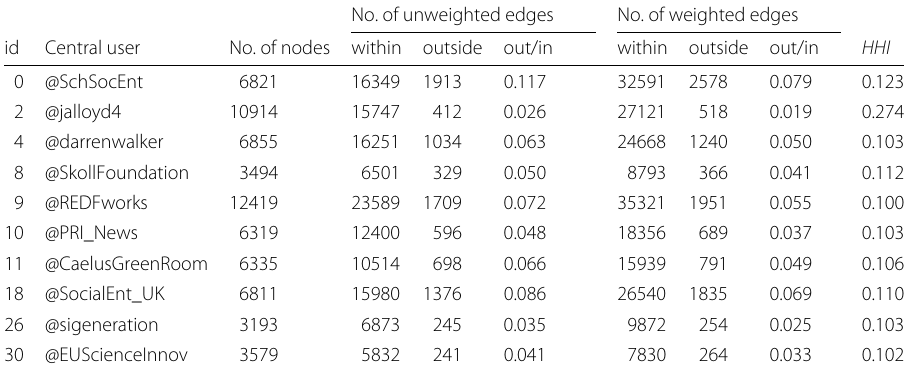
Table 4 Structural properties of the main retweet communities. HHI is computed for N = 10 top users in each community No. of unweighted edges No. of weighted